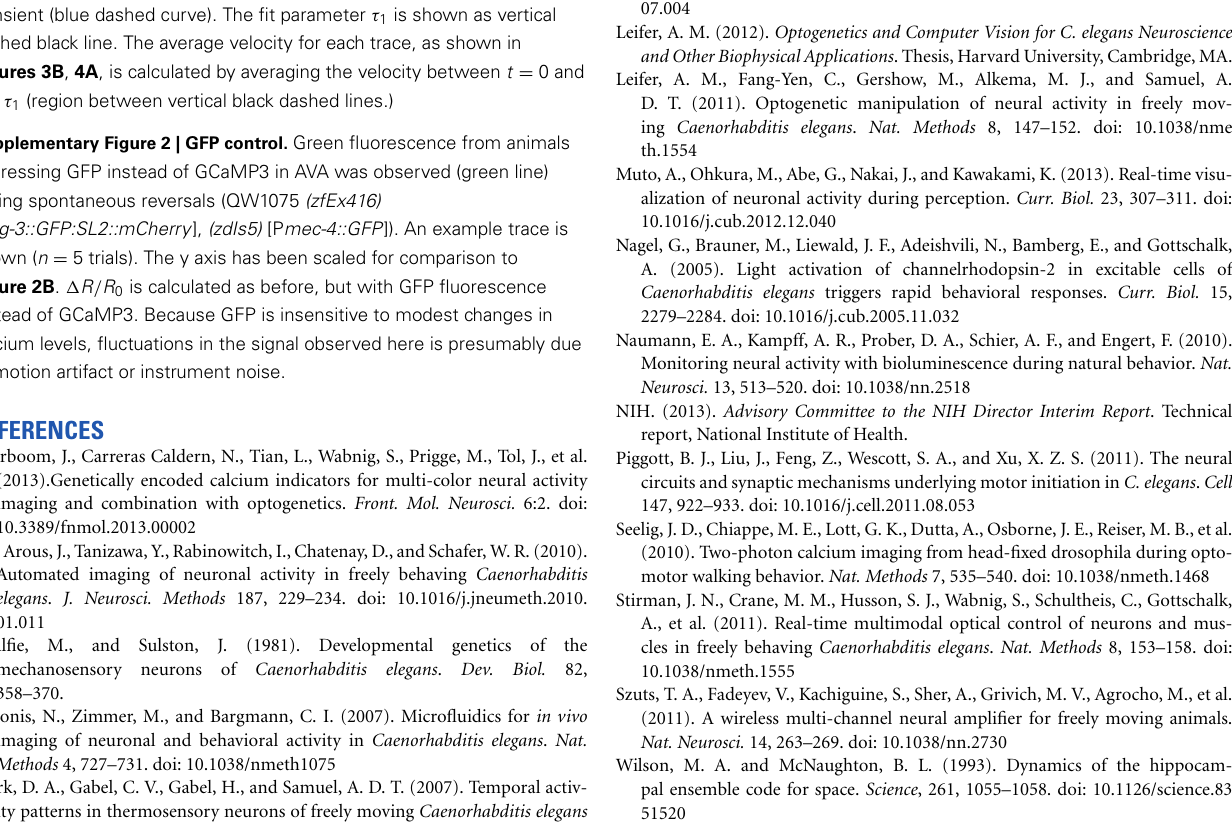
Supplementary Figure 2 | GFP control. Green fluorescence from animals expressing GFP instead of GCaMP3 in AVA was observed (green line) during spontaneous reversals (QW1075 (zfEx416)